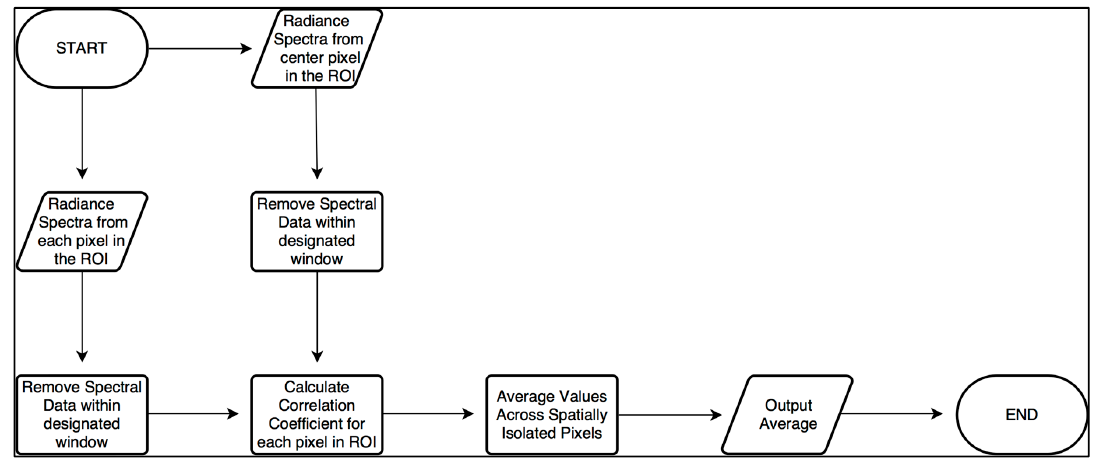
Figure 7. Schematic view of the basic algorithm for the application of the CC in the spectral localization of errors in HSI data.